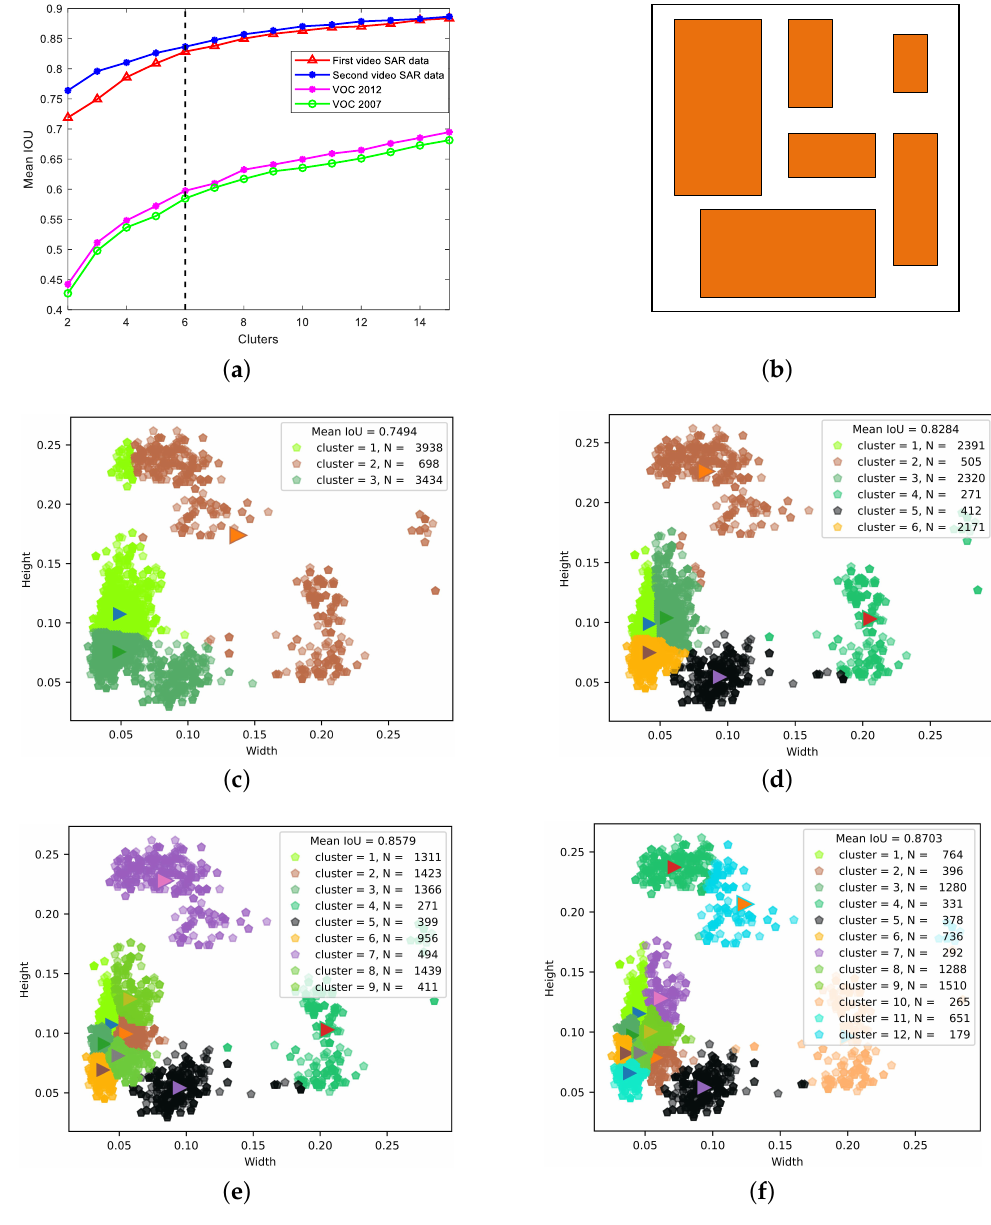
Figure 24. Clustering box dimensions on different datasets. ( a ) Graph of mean IOU against the value of K . ( b ) The relative anchors for the first video SAR dataset at K = 6. ( c – f ) Clustering results on the first video SAR dataset at K = 3,6,9, and 12, respectively. Since the width and height of the targets in the images are different, they are first